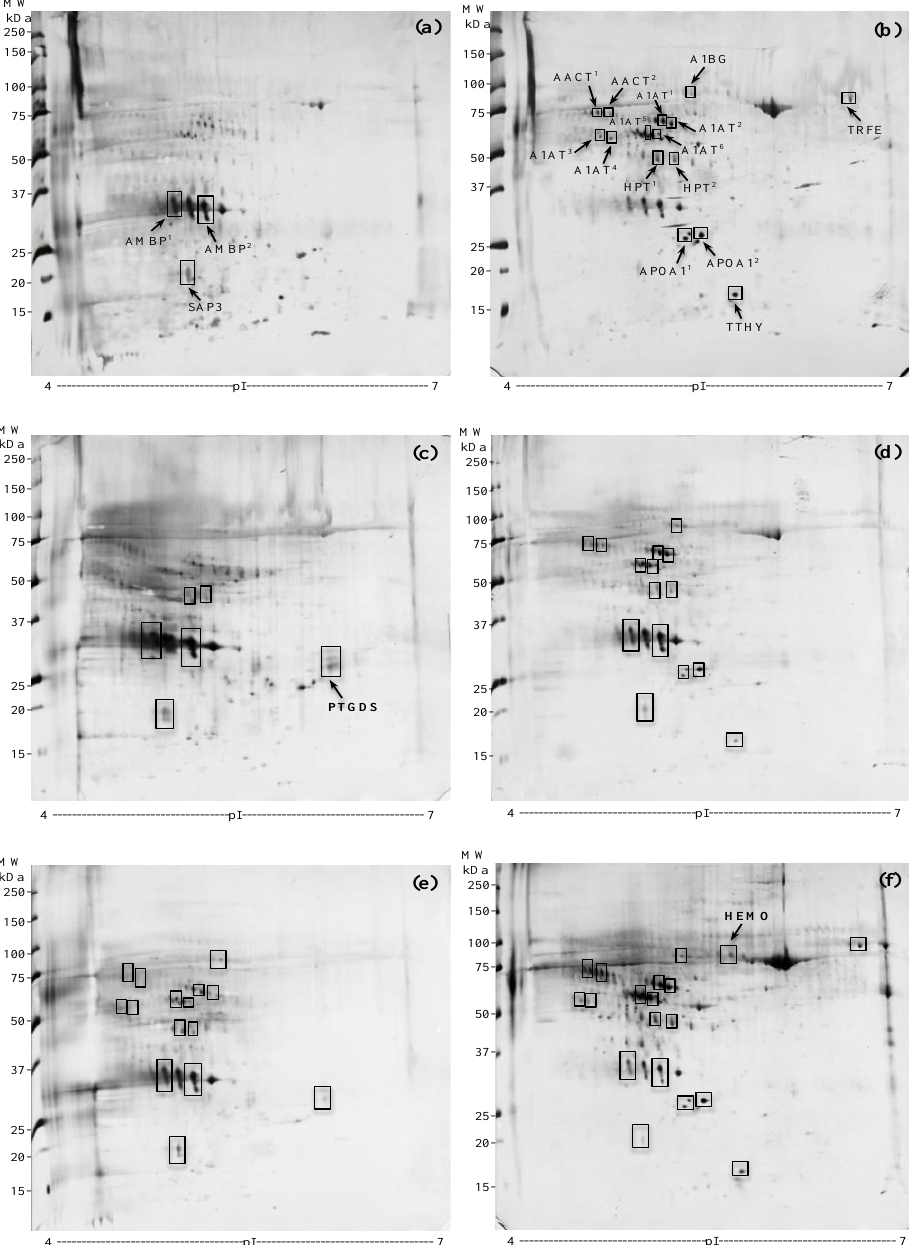
Figure 2. Representative urinary 2D gels; ( a ) PCa group (all PCa patients with and without inflam- mation); ( b ) BPH group (all BPH patients with and without inflammation); ( c ) noI-PCa group (PCa patients without inflammation); ( d ) noI-BPH group (BPH patients without inflammation); ( e ) I-PCa group (PCa patients with inflammation); ( f ) I-BPH group (BPH patients with inflammation). The significantly different spots are enclosed in rectangles, and in panels ( a – c , f ) are included the protein entry names, corresponding to those reported in Table 3. AMBP, Alpha-1-microglobulin; SAP3, Ganglioside GM2 activator; AACT, Alpha-1-antichymotrypsin; A1BG, Alpha-1-beta-glicoprotein; TRFE, Serotransferrin; A1AT, Alpha-1-antitrypsin; HPT, Haptoglobin; APOA1, Apolipoprotein A1; TTHY, Transthyretin; PTGDS, Prostaglandin-H2 D-isomerase; HEMO, Hemopexin.